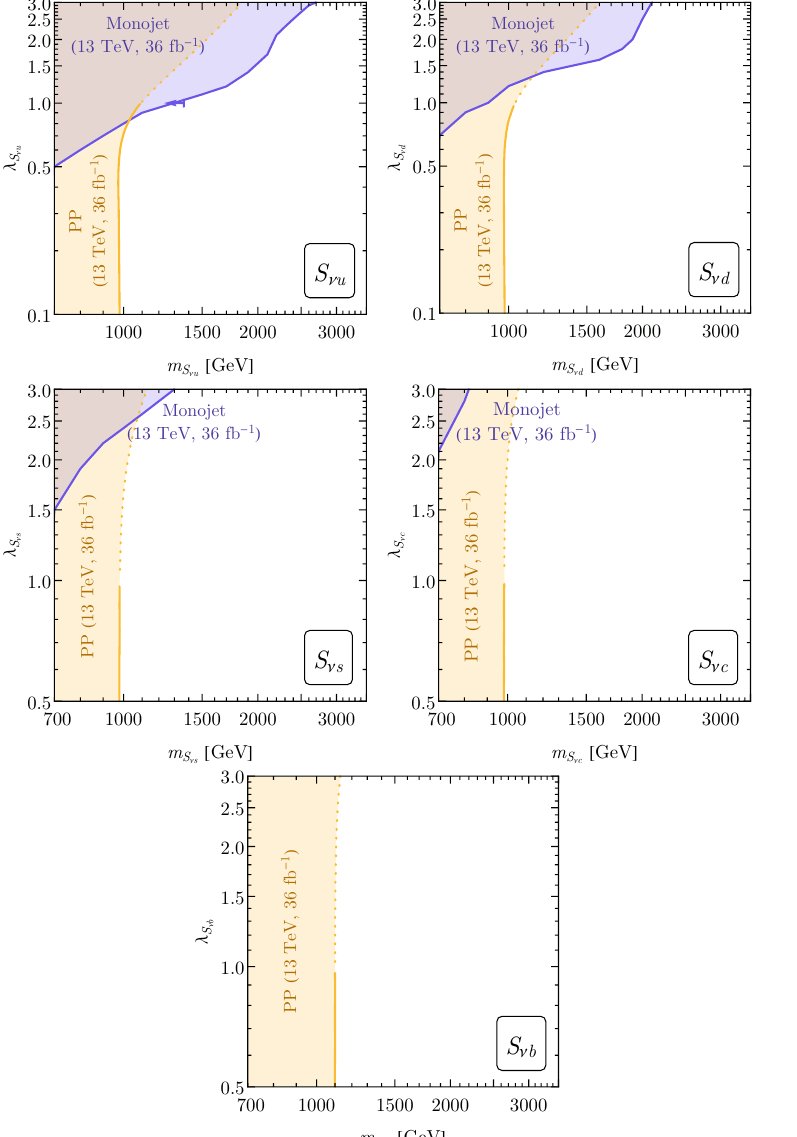
Figure 12. 95% CL limit on the parameter space for the scalar MLQ S decays into the (cid:23)j (cid:12)nal state. The pair production and the monojet search limits are recast from [27] and [74], respectively. The arrow in the S (cid:23)u plot indicates the bound on m S (cid:21) S = 1 from (cid:23)u